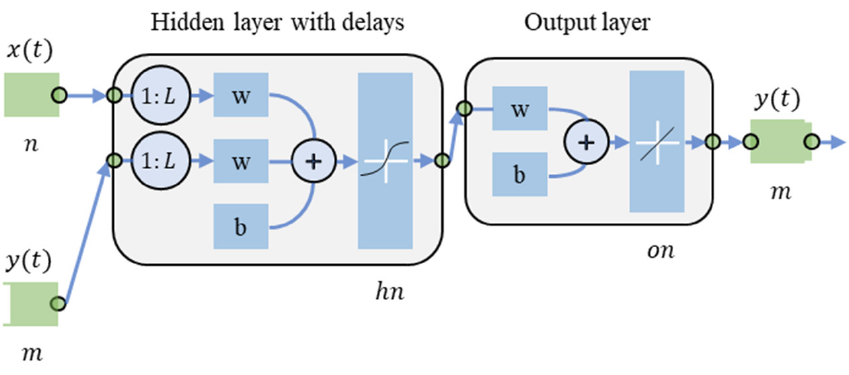
Figure 10. The general arrangement of the neural networks model.